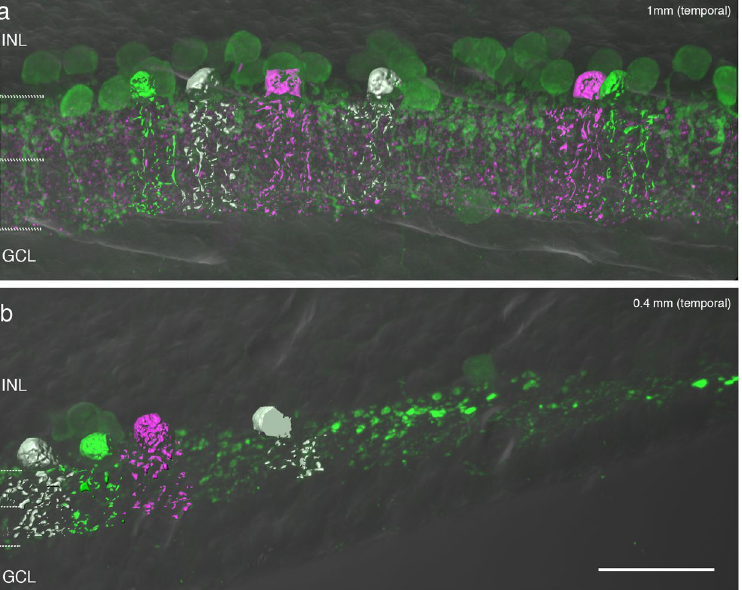
Figure 3. Reconstructions of AII amacrine cells in macaque retina. Three-dimensional views of a vertical vibratome section at ( a) 1 mm and ( b) 0.4 mm eccentricity. The section was processed with antibodies against calretinin (green) and calretinin positive cells were reconstructed. The OFF and ON sublamina of the inner plexiform layer are indicated on the left of the image. INL, inner nuclear layer; GCL, ganglion cell layer. Scale bar shown in b = 25 µ m (valid for a and